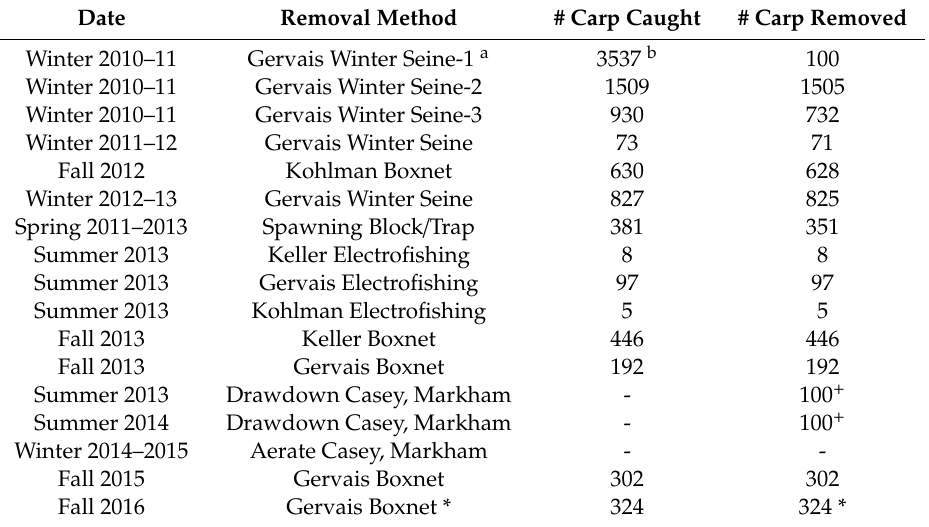
Table 3. Common carp control e ff orts and results in the Lake Phalen Chain of Lakes (previously published data is referenced, the rest is from various data reports to the